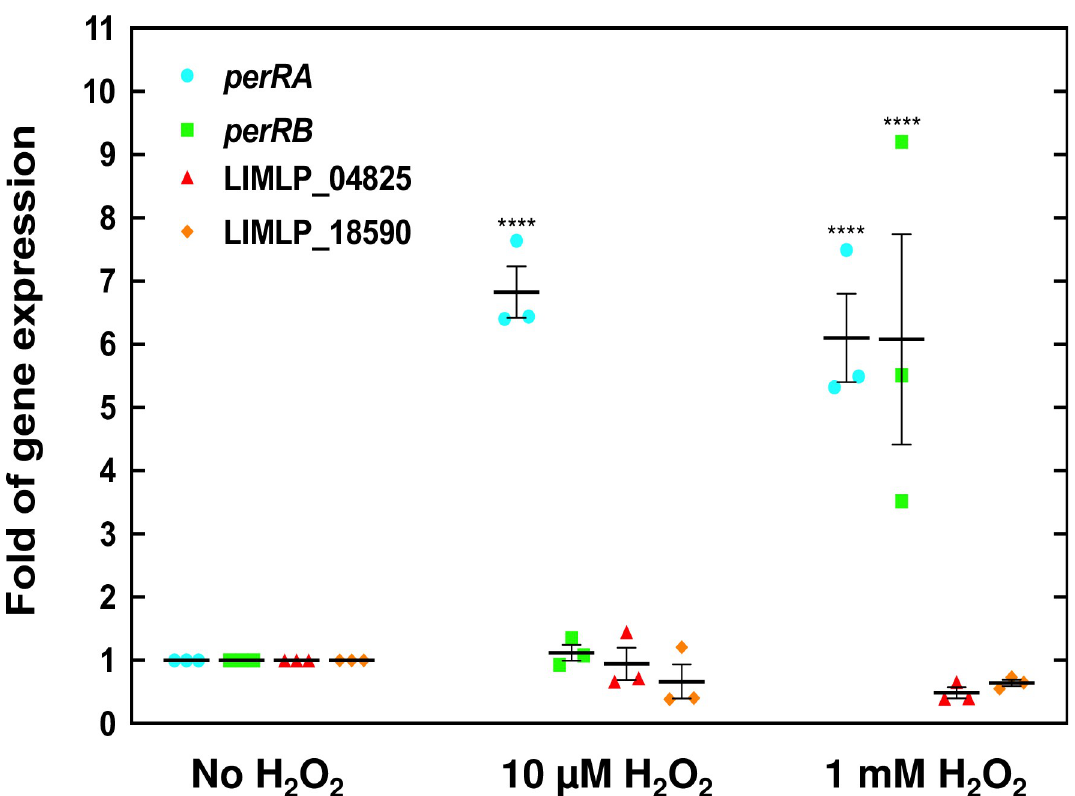
Fig 4. Increased perRA and perRB expression upon exposure to hydrogen peroxide. Exponentially growing L . interrogans were incubated in the absence or presence of 10 μ M (for 30 min.) or 1 mM H 2 O 2 (for 60 min.) and the expression of perRA (cyan circles), perRB (green squares), LIMLP_04825 (red triangles) and LIMLP_18590 (orange diamonds) was measured by RT-qPCR as described in the Materials and Methods section using flaB as reference gene. Gene expression was normalized by that in untreated samples. Data are the means and standard errors of three independent biological replicates. Two-way Anova test indicated statistical significance in comparison with untreated samples ( ���� , p-values < 0.0001).